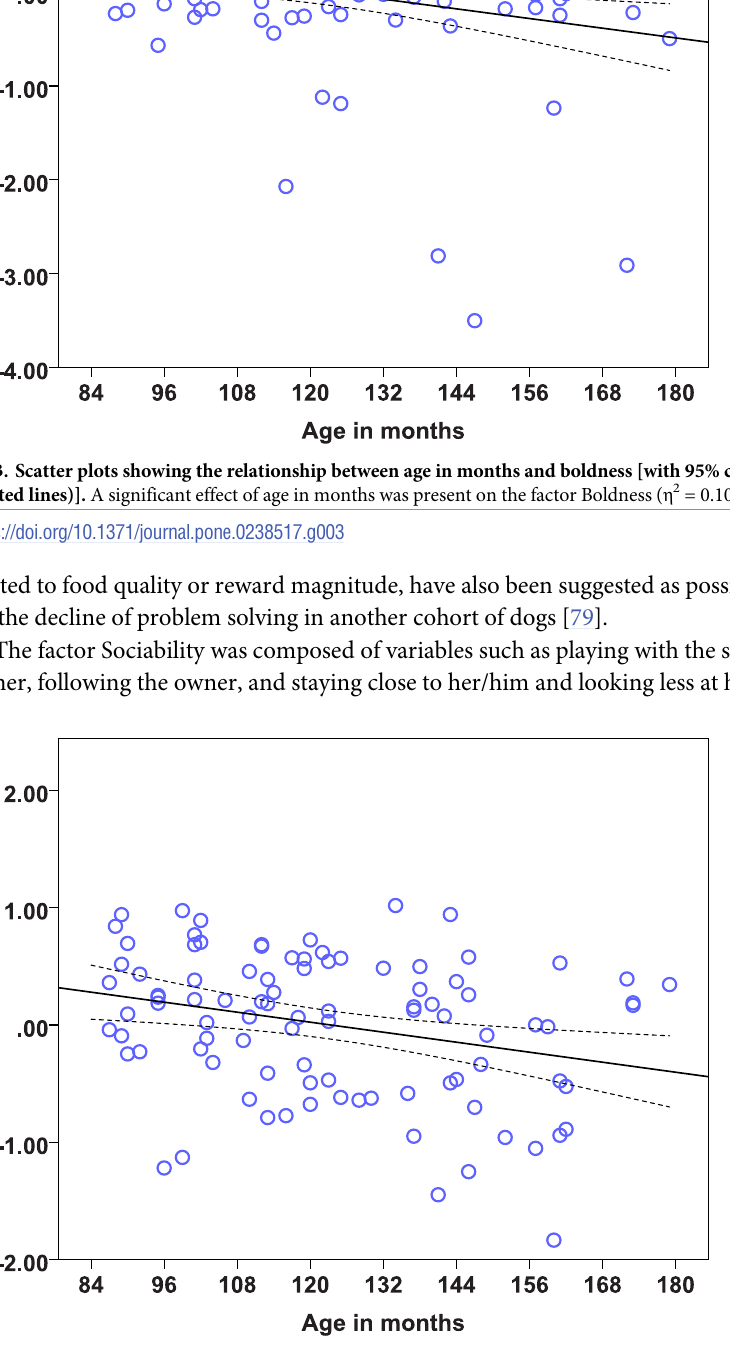
Fig 4. Scatter plots showing the relationship between age in months and dependency [with 95% confidence intervals (dotted lines)]. A significant effect of age in months was present on the factor Dependency ( η 2 = 0.07, p =